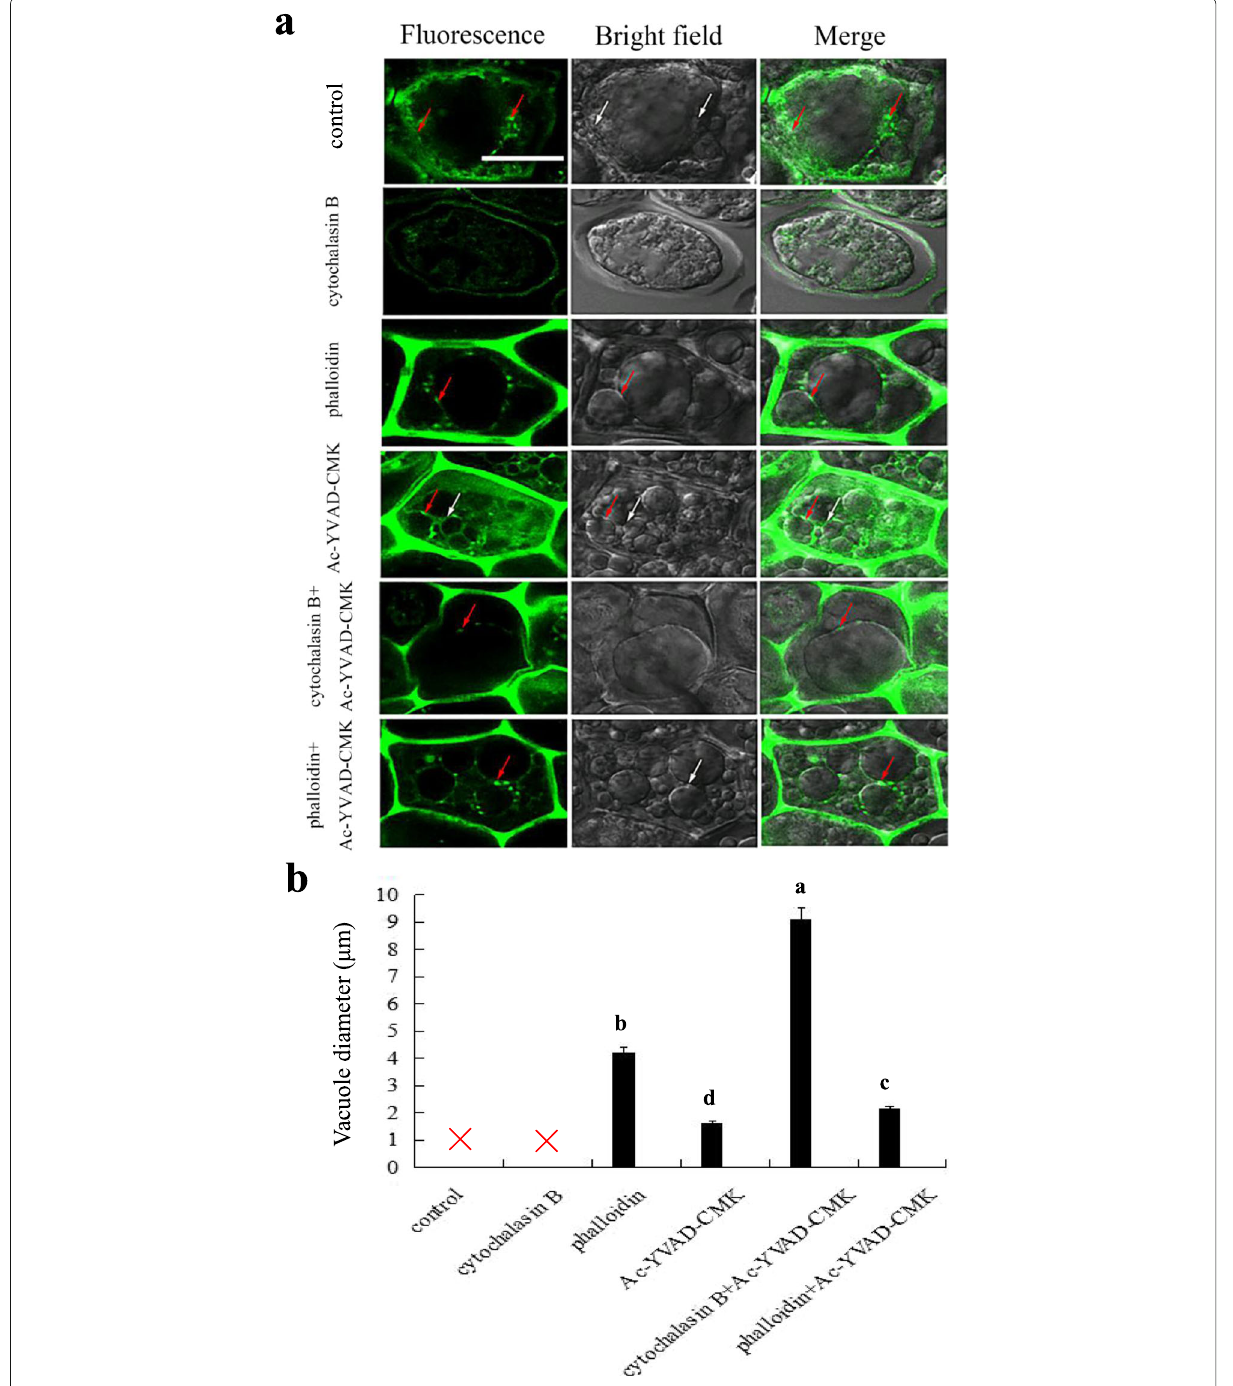
Fig. 6 Depolymerization blocked the process of vacuole fusion. Aleurone layers were stripped from the intact seeds imbibed for 12 h, and then the isolated layers were incubated in a solution containing distilled water (control) alone or 10 μ g/mL phalloidin (AF depolymerization inhibitor), 10 μ g/mL cytochalasin B (CB) (AF depolymerizer), 10 μ M Ac-YVAD-CMK (caspase-1 inhibitor) alone or in combination for 7 d, the layers were labeled with FITC-phalloidin, a the organization of AF (green) was observed by LSCM, and images were immediately captured. Scale bar is 10 μ m. b Statistical analyses were conduced on the vacuole diameter per cell. Red cross represents the ruptured large central vacuole. Error bars indicate the means ± s.d., n = 3 biological independent experiments with at least three replicates for each. Bars with different alphabets show significant different at P < 0.05 according to Duncan’s multiple range